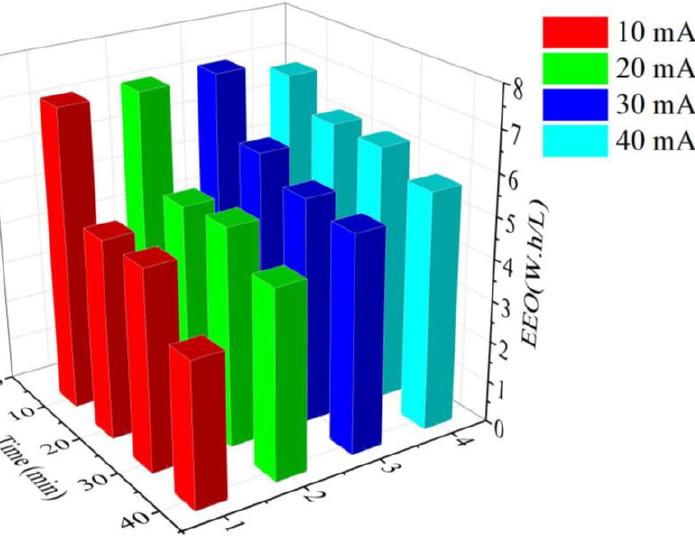
Figure 7. Energy consumption per order for the electrochemical degradation of norfloxacin under the various conditions of the current density and the inter-electrode distance.